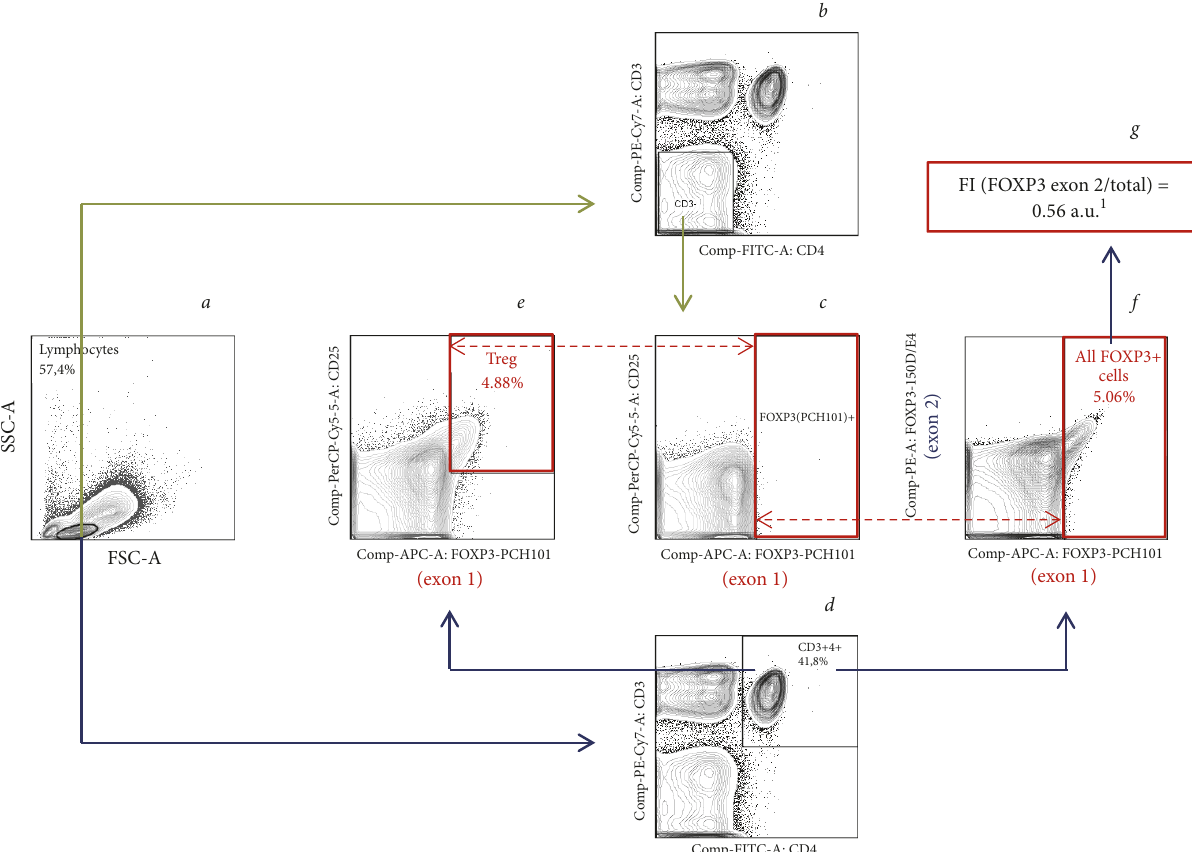
Figure 1: Flow cytometry. The algorithm of regulatoryT cells gating using PBMCs 2 of the 74-year-old healthy donor. ( a ) Lymphocytes among PBMCs. ( b–c ) Establishing FOXP3 + gate using CD3 − cells known not to express FOXP3: CD3 − cells among lymphocytes ( b ); establishing FOXP3 (exon 1) + gate using CD3 − cells ( c ). ( d–e ) Detection of Treg: CD4 + T cells among lymphocytes ( d ); CD25 + FOXP3 (exon 1) + – Treg among CD4 + T cells ( e ). ( f–g ) Analysis of FOXP3 isoform expression: all FOXP3 + cells among CD4 + T cells ( f ); calculation of FI (FOXP3 exon 2/total) parameter in all FOXP3 + cells = [(FOXP3 exon 2 MFI)/(FOXP3 exon 1 MFI)] ( g ). The solid arrows show the gating algorithm. The dashed bidirectional arrows show the alignment of the established gates for CD3 − and CD3 + CD4 + cells. 1 a.u.: arbitrary units; 2 PBMCs: peripheral blood mononuclear